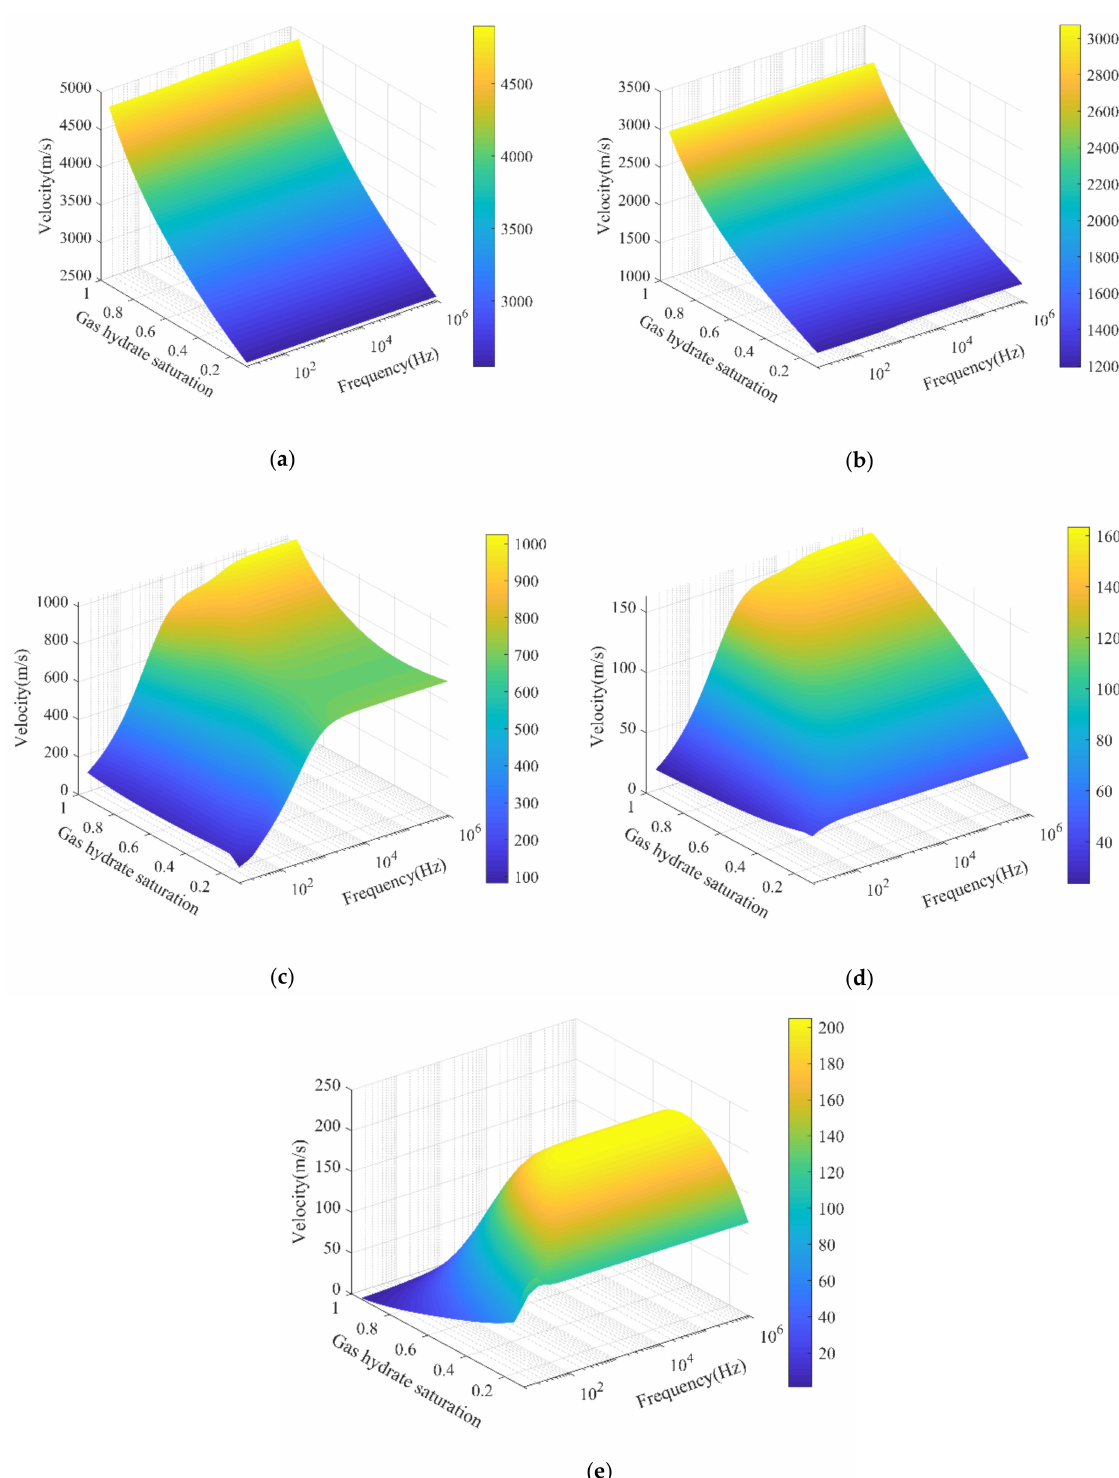
Figure 4. Effects of frequency and hydrate saturation on the phase velocities of five waves: ( a ) P1; ( b ) S1; ( c ) P2; ( d ) S2; ( e )